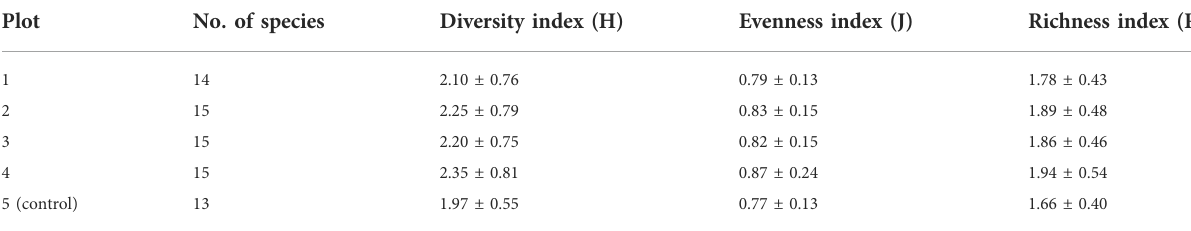
TABLE 3 Comparison of the community diversity, evenness, and richness of the different plots. Plot No. of